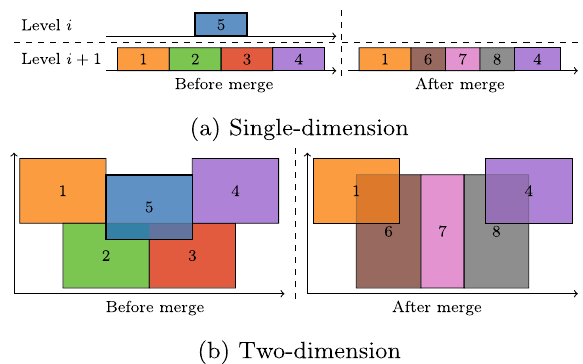
Fig. 9 Components’ key boundaries before and after a merge, where components 2, 3 and 5 are merged and replaced by 6, 7 and 8 (illustration purpose only, not from real data)